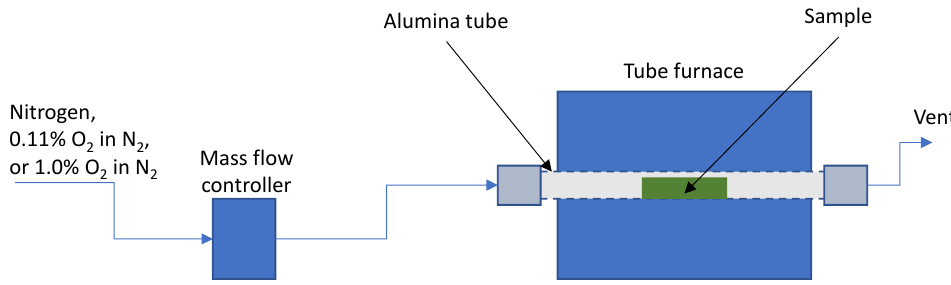
Figure 1. The schematic view of the pyrolysis furnace.